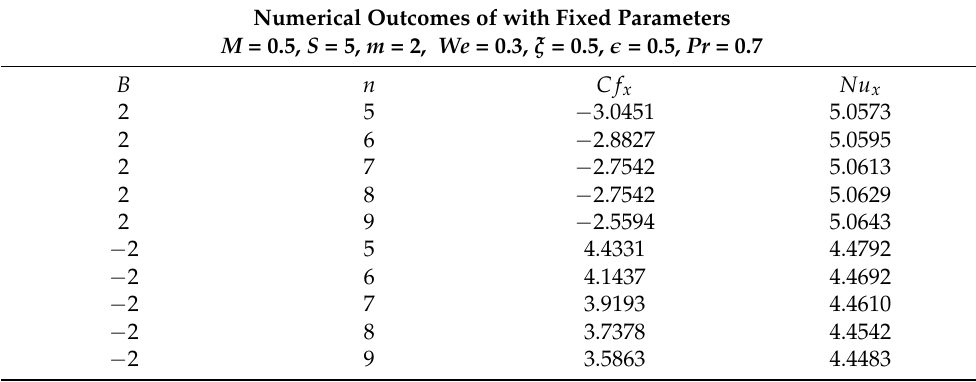
Table 2. The numeric results of the shear stress and Nusselt number under the influence of stretching ratio and power law